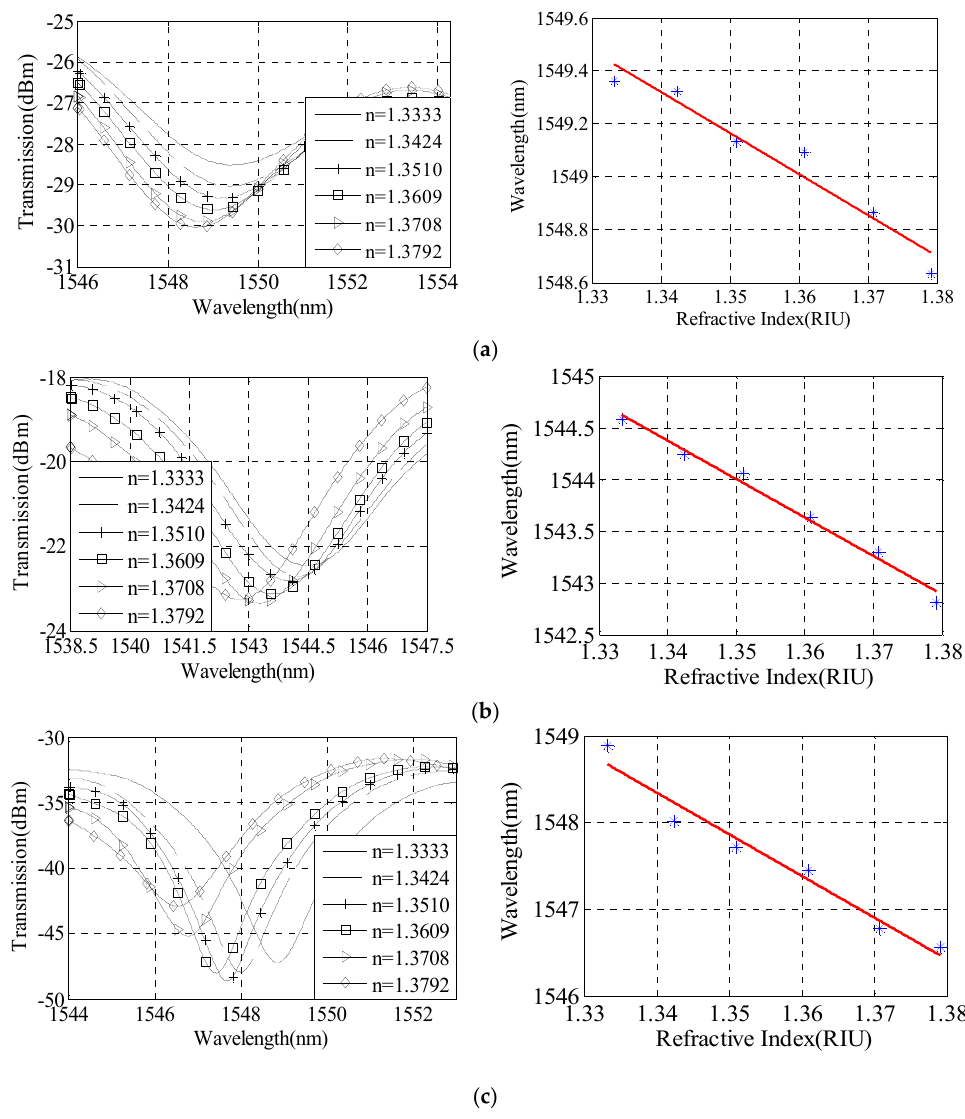
Figure 7. Refractive index measurement sensitivity analysis with different taper waist diameters. ( a ) D = 30 μ m; ( b ) D = 25 μ m; ( c ) D = 20 μ m.